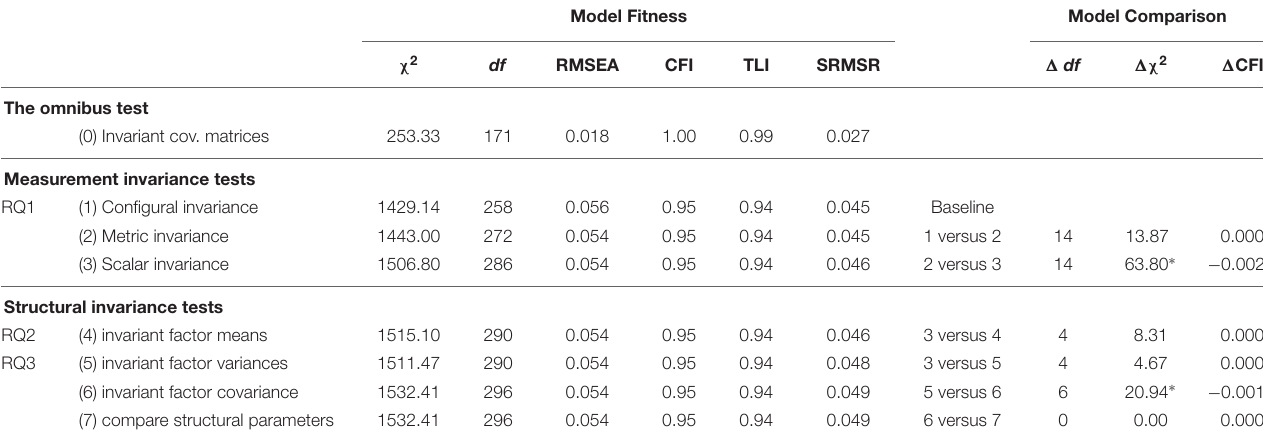
TABLE 3 | Invariance tests across genders.